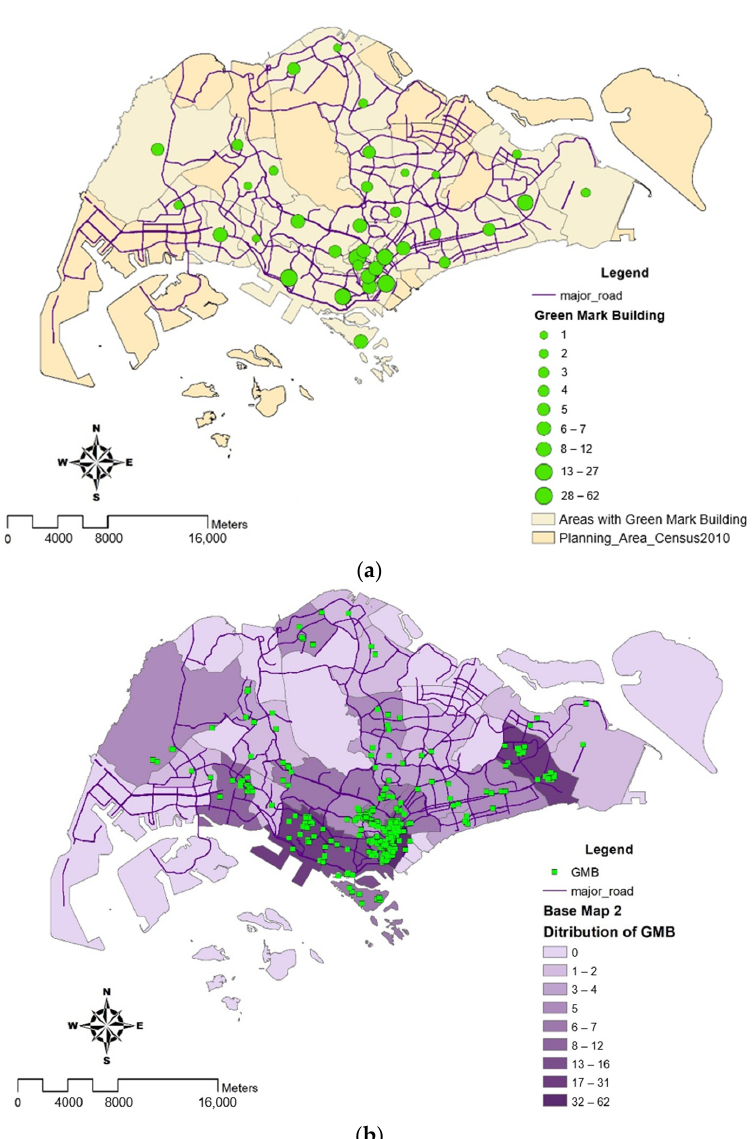
Figure 7. ( a ) The map displays the cluster of Green Mark Buildings (GMB) where larger cluster circle represents the higher number of GMB in a planning area. ( b ) Concentration of Green Mark Buildings (GMB). The map displays the distribution of GMB using the classification technique ‘Natural Breaks’, with dark colors indicating large concentration of GMB and light colors indicating either no or tiny concentration of GMB.